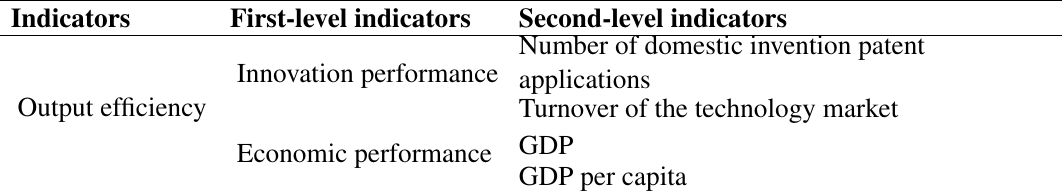
Table 3 Comprehensive Evaluation Index System of Policy Output of Government Guidance